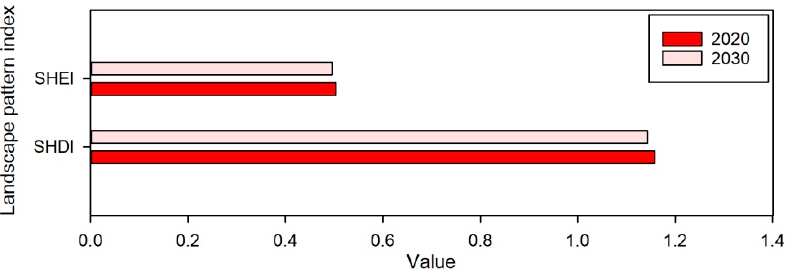
Figure 10. Landscape pattern index (SHDI and SHEI) contrast analysis between 2020 and